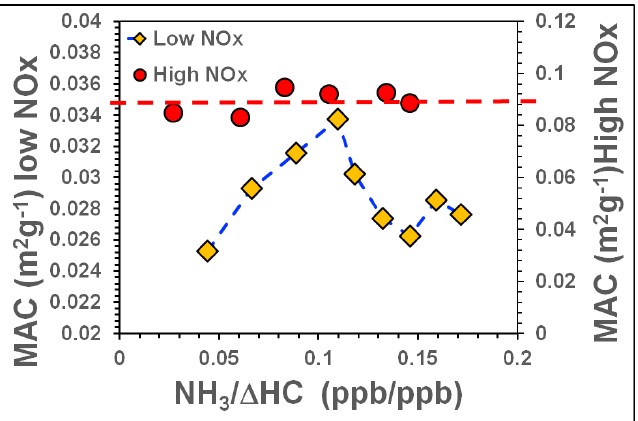
Figure 10. MAC as a function of the ([NH 3 ]/[ ∆ HC]) ratio at 80% RH under low and high NO x scenarios. Blue and red dotted lines are the eye guiding lines for low and high NO x scenarios, respectively. The dashed lines are included to guide the